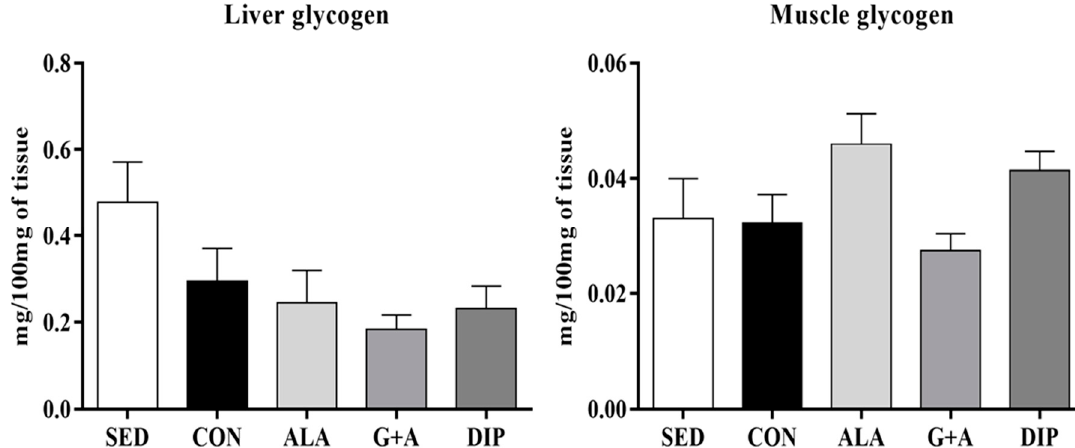
Figure 2. Liver and muscle glycogen of rats submitted to resistance training and supplementation with L -glutamine and L -alanine. SED: sedentary group, CON: trained group, ALA: trained and supplemented with alanine, G + A: trained and supplemented with glutamine and alanine in their free form, and DIP: trained and supplemented with L -alanyl- L -glutamine. Data are presented as mean ± SD.